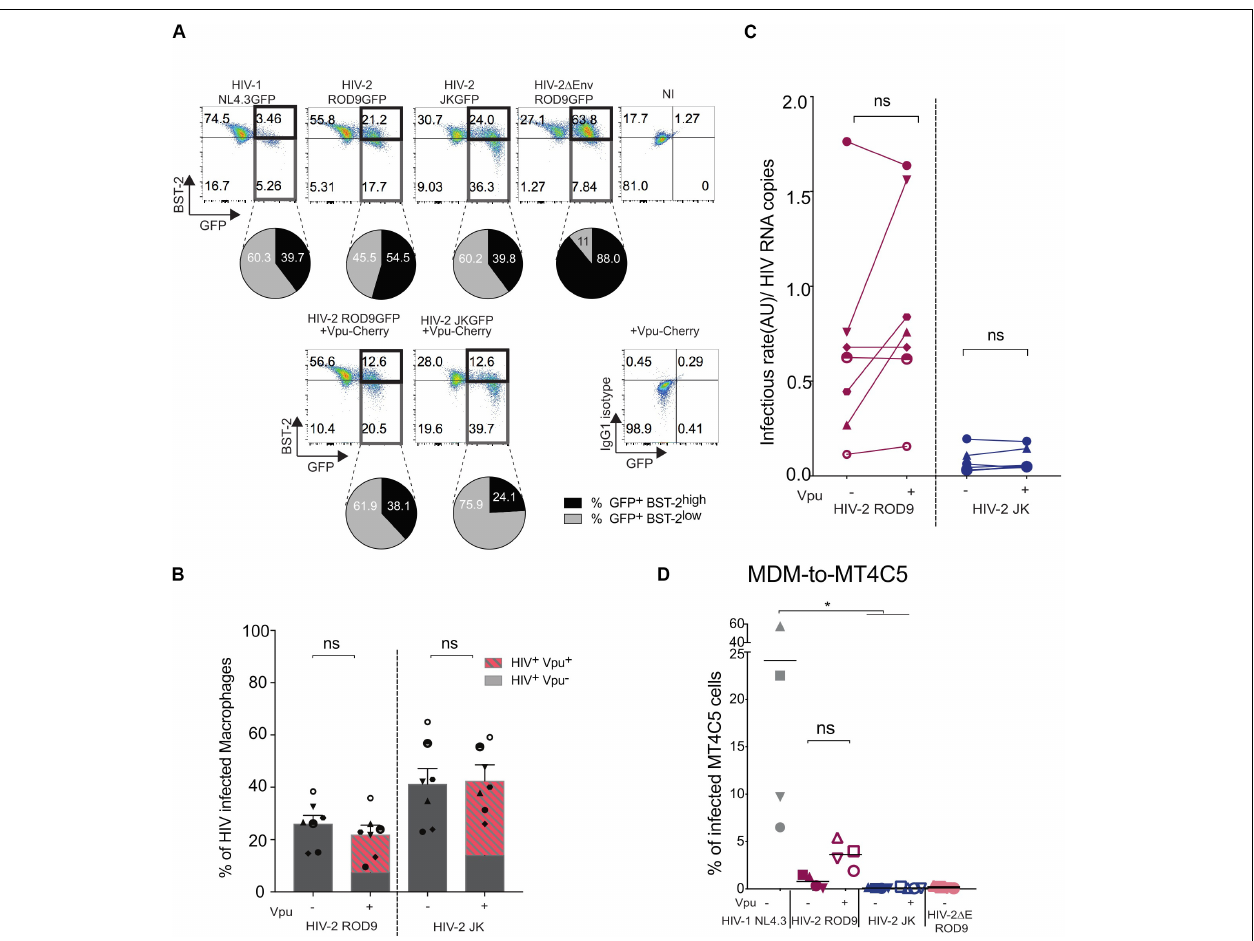
FIGURE 7 | Vpu-induced downregulation of BST2 does not rescue infectivity of the viral particles produced by HIV-2-infected MDMs. MDMs were infected with the indicated HIV or not (NI = non-infected) supplemented with lentiviral particles encoding the fusion protein Vpu-Cherry. At 3 dpi, cells were recovered, fixed and stained for BST2. (A) Representative dot plot of BST2 versus GFP expression. GFP + BST2 low cells are boxed to ease comparisons. Pie charts represent BST2 expression within the infected GFP + cells. Isotype control staining is shown at the bottom right. (B) Rates of infection were evaluated by measuring the percentage of GFP + MDM exposed or not to Vpu-Cherry lentiviral particles. Percentages of GFP + cells and of GFP + Vpu + (in dashed red) are displayed. Each symbol represents a donor ( n = 7 from 4 independent experiments). Bars represent the mean ± SEM. (C) Infectivity of the released viruses +/– Vpu, calculated as rate of infection/HIV RNA copies measured as Figure 5E (see also Supplementary Figure S5 ). For (B,C) P -values were calculated using matched-pairs Wilcoxon non-parametric test. P -values lower than 0.05 were considered as significant. (D) Addition of Vpu to HIV-2 ROD9-infected MDMs partially rescues transmission to MT4C5 cells. Percentages of GFP + MT4C5 cells, which is a CD4 + CCR5 + CXCR4 + T cell line, after co-culture with MDMs infected with indicated HIV +/– lentiviral particles encoding Vpu-Cherry. n = 4 from 2 independent experiments with bars representing the mean. P -values were calculated using paired Friedman non-parametric multiple comparison test. P -values lower than 0.05 were considered as significant (* p < 0.05, ** p < 0.01, *** p < 0.001, **** p <